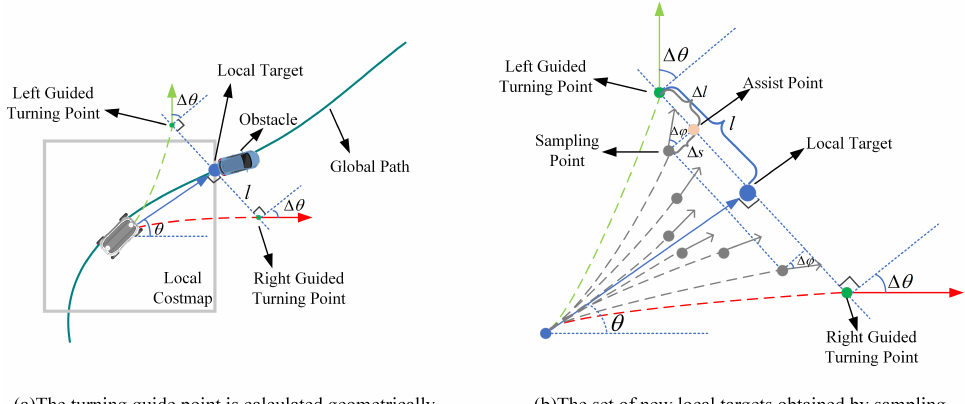
Figure 6. An obstacle avoidance strategy to cope with dynamic obstacles falling on local